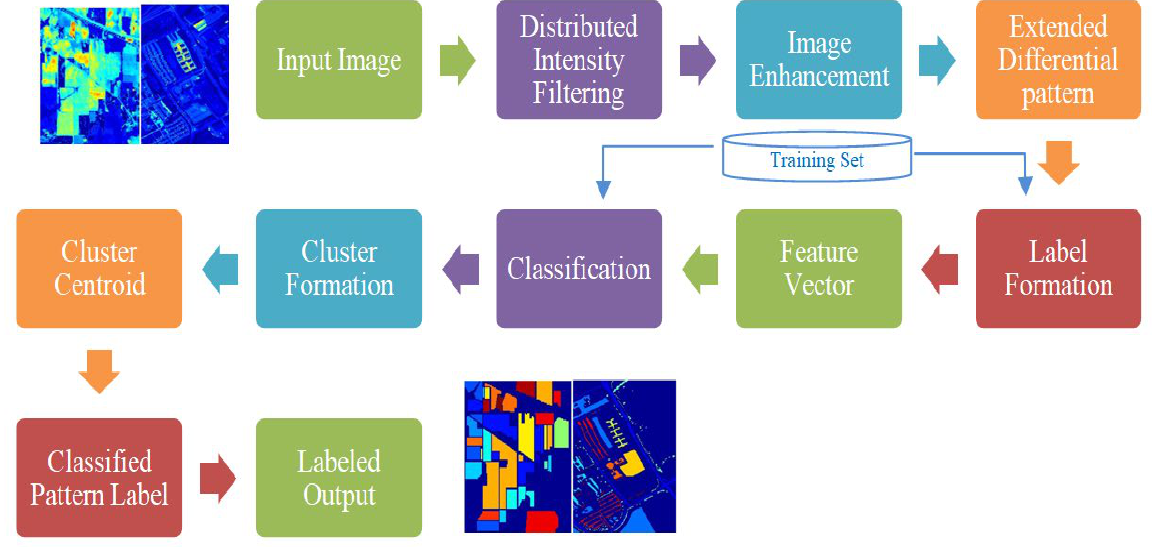
Figure 1. Workflow of proposed